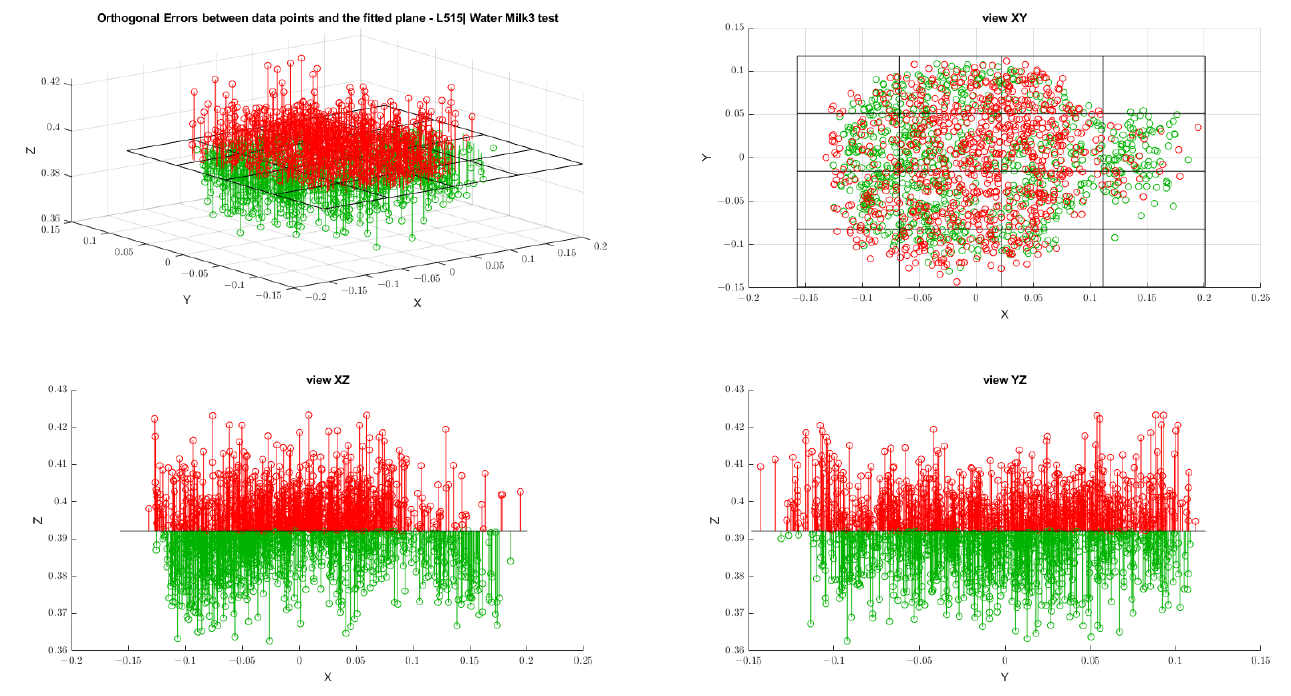
Figure A13. Results of orthogonal errors for the L515 camera referring to the water milk3 test.